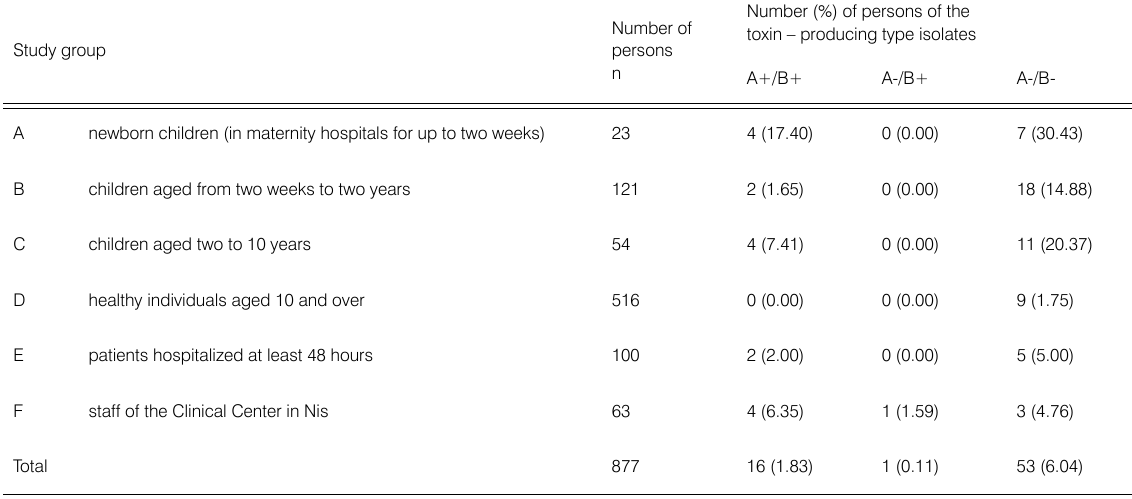
Table 3. The finding of toxin - producing type isolates of Clostridium difficile in six study groups